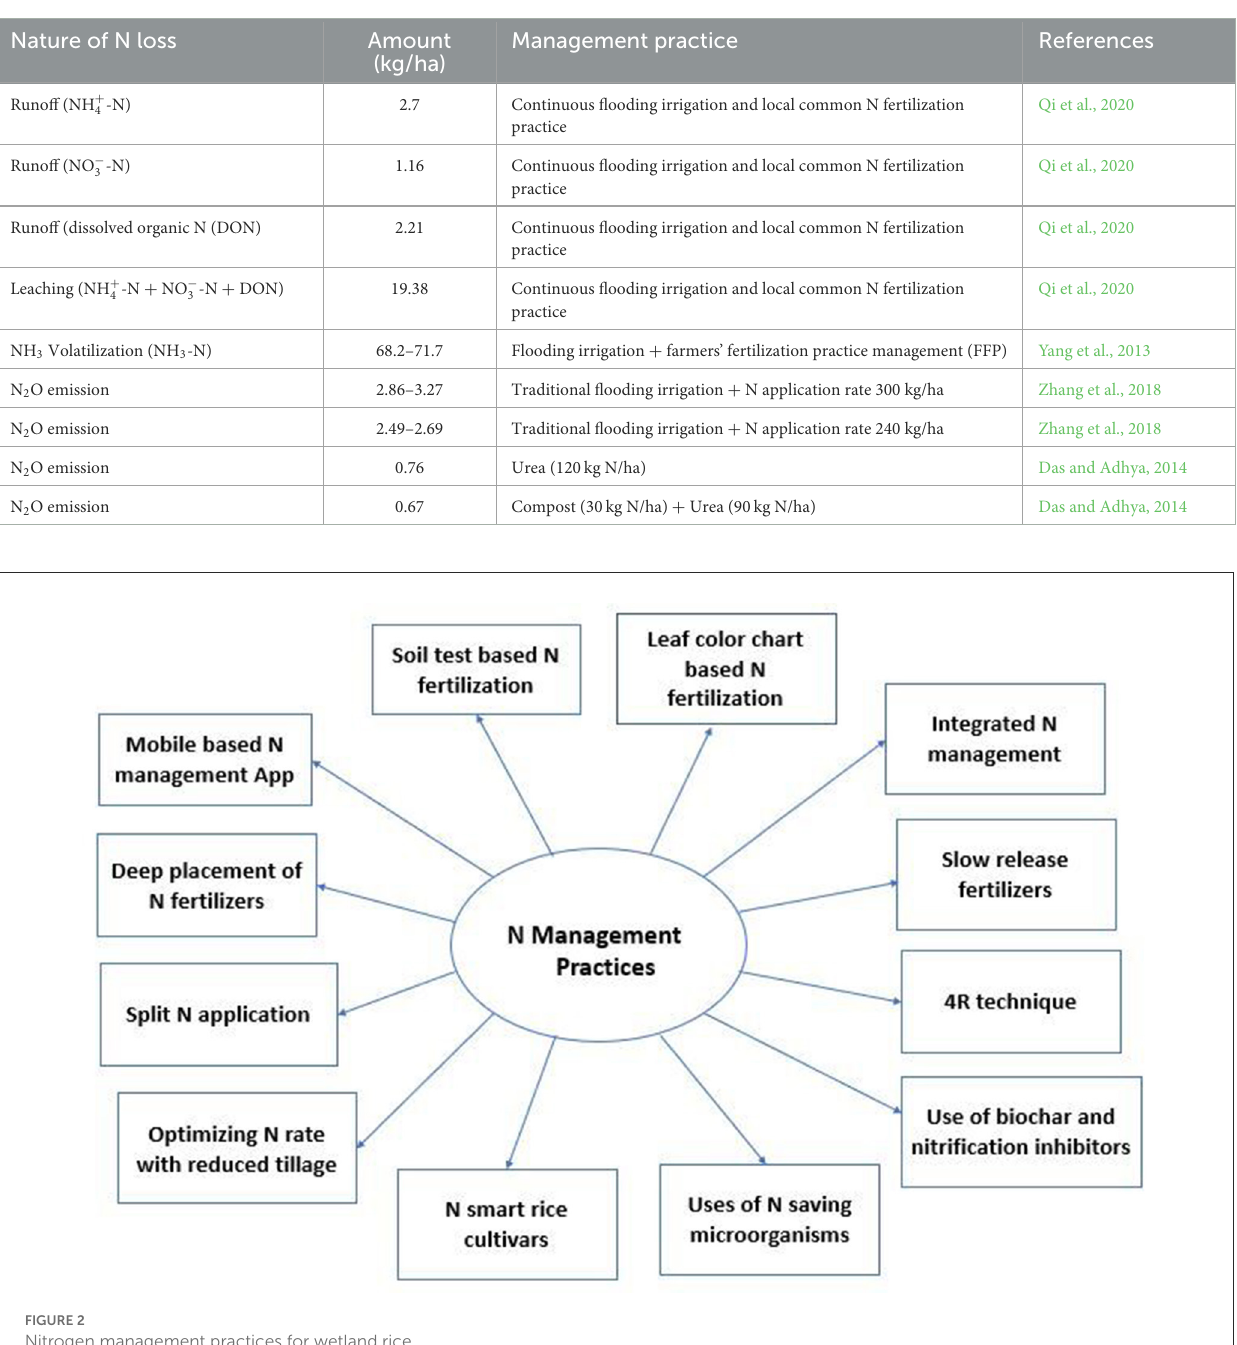
TABLE 2 Amount of nitrogen losses (kg/ha) from paddy field.